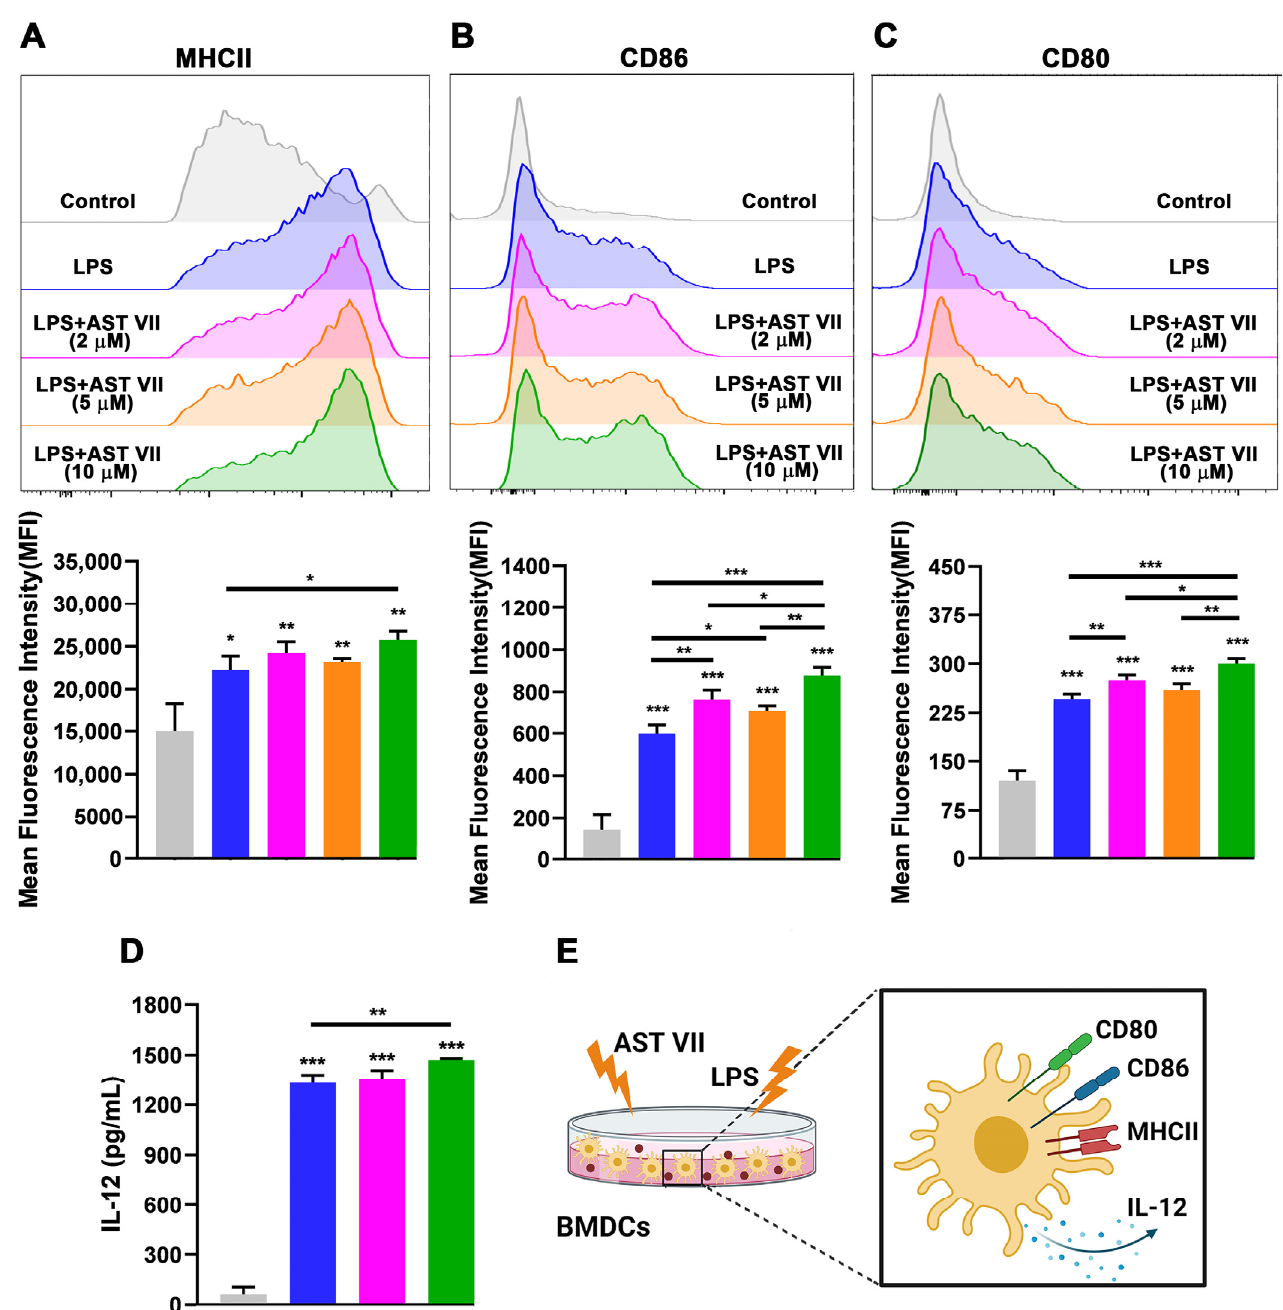
Figure 4. AST VII induces the maturation and activation of BMDCs in the presence of LPS. BMDCs generated from C57BL/6 mice bone marrow cells were co-treated with LPS (10 ng/mL) and AST VII at the concentrations of 2, 5, or 10 μ M for 24 h. The expression of ( A ) MHCII, ( B ) CD86, and ( C ) CD80 on CD11c + MHCII + BMDCs was determined using flow cytometry. For ( A – C ), representative histogram (top panel) and summary graphs (bottom panel) are shown. ( D ) IL-12 titers were measured using ELISA. ( E ) Schematic illustration of DC maturation/activation after the treatment with AST VII and LPS. Data shown are mean ± SD of triplicates and representative of three independent experiments with similar results. Statistically significant differences in the treated group were analyzed compared to the control (untreated cells). Intragroup and intergroup comparisons were performed using one-way ANOVA and Tukey’s multiple comparison test. * p < 0.05, ** p ≤ 0.01, *** p ≤ 0.001. Created with BioRender.com.